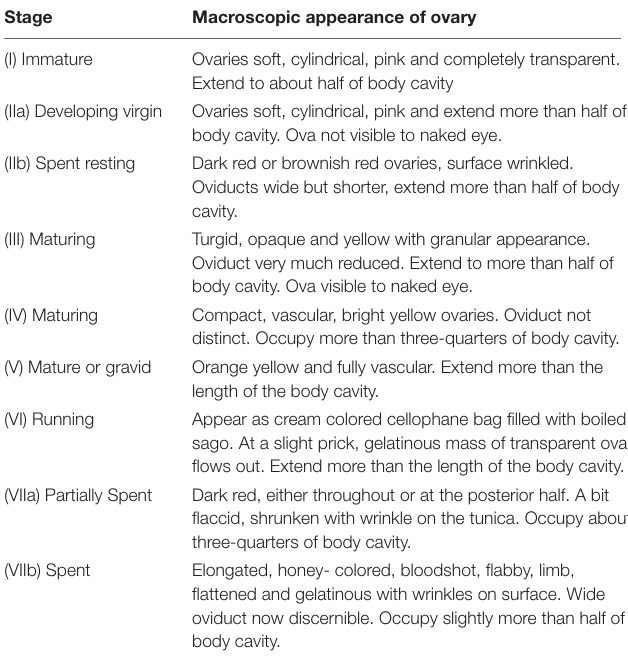
TABLE 2 | Maturity staging of female Sardinella longiceps by macroscopic analysis used in the study following Raja (1966). Stage Macroscopic appearance of